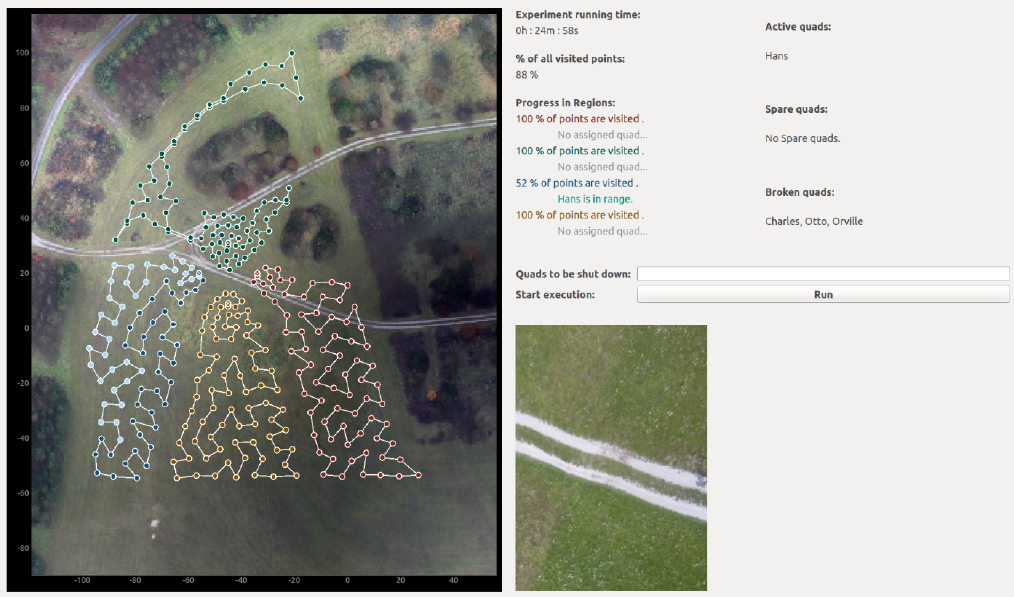
Figure 4. GUI for swarm control and data